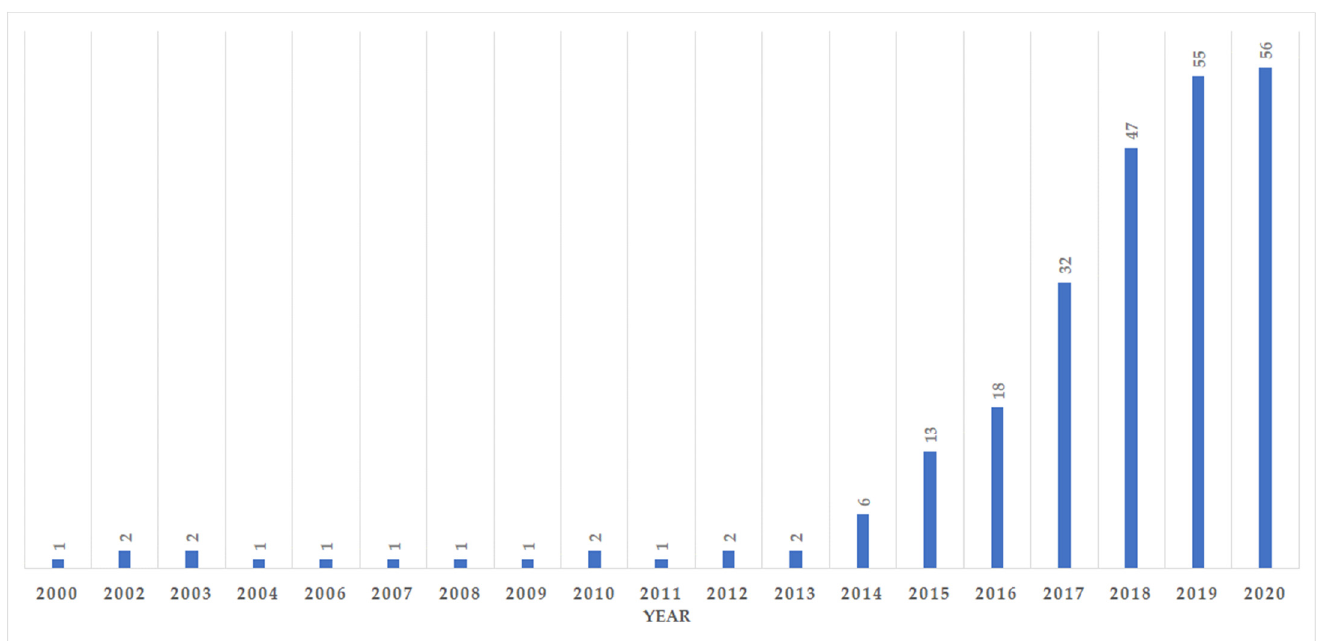
Figure 2. Annual publications of climate-smart agriculture research articles showing a steady increase from an average of 1 publication per year between 2000 and 2010 to 56 publications in the year 2020.